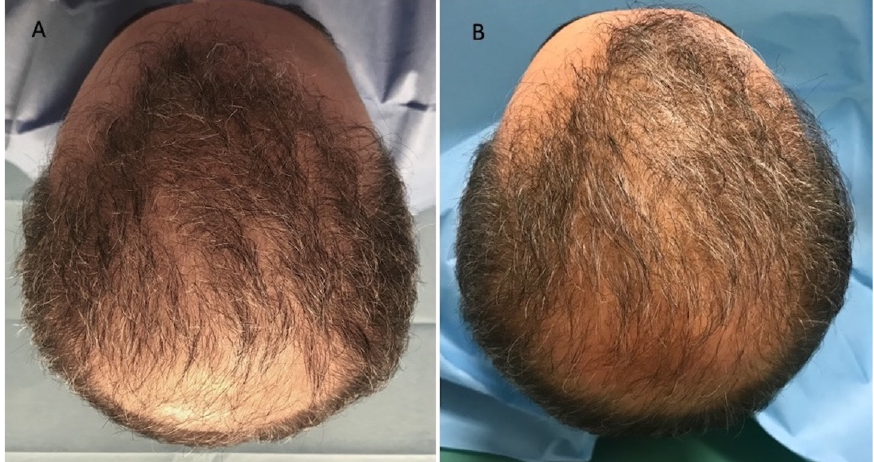
Figure 4. Caucasian male patient treated with LLLT, MND, and GFs protocol. ( A ) Pre-operative view of the scalp of a 68 year-old male patient affected by AGA of III vertex degree according to the Norwood scale, with hair loss localized in the frontal, temporal, parietal, and vertex areas; ( B ) post-operative view at T1 (20 wks) after treatment with detail of HR-G in the treated areas (frontal, parietal, and vertex). Table 1. Patient characteristics.